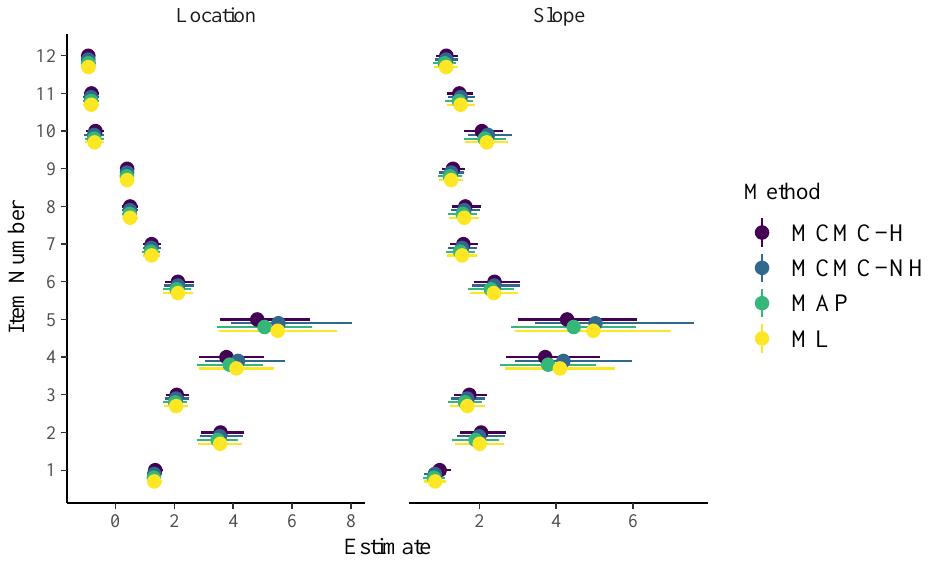
Figure 2. Item parameters of the 2PL model. Horizontal lines indicate 95% uncertainty